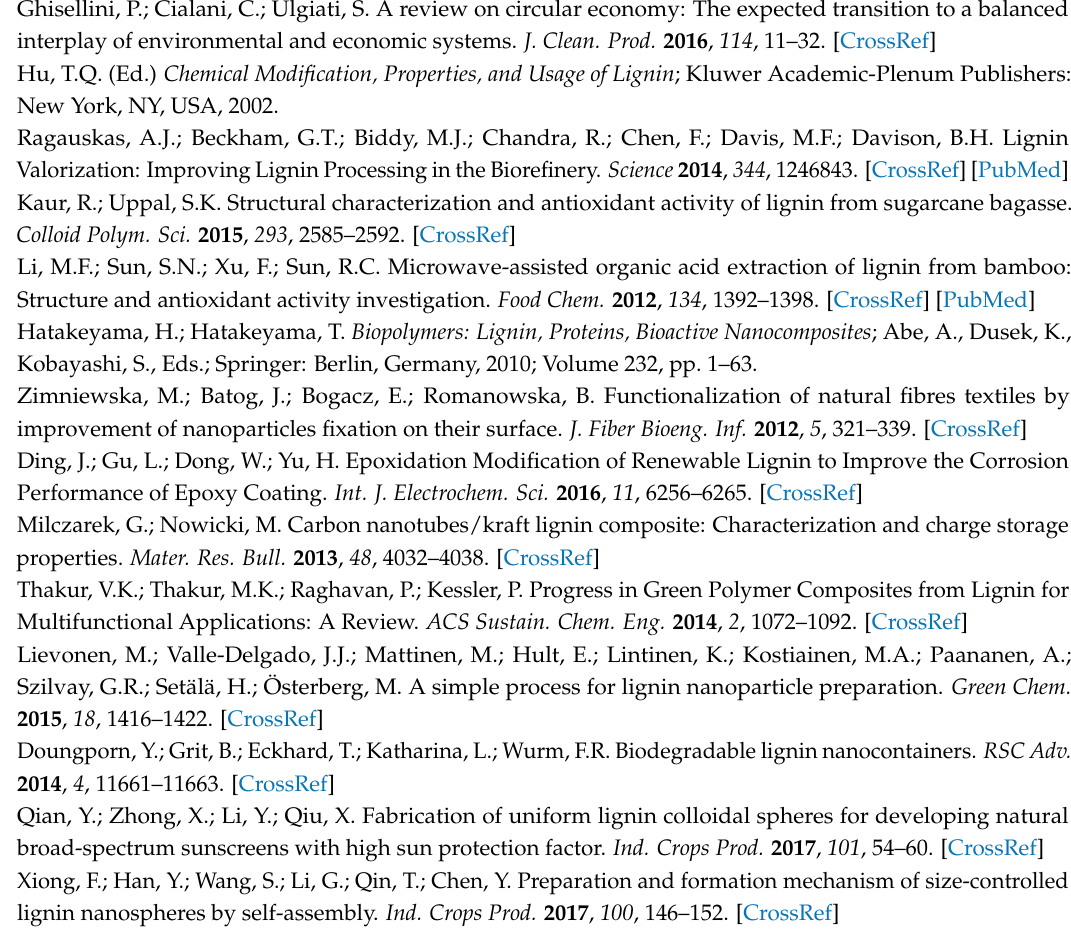
Figure S1: Gel Permeation Chromatography (GPC) of lignin Organosolv (OL black line) and after the treatment with tyrosinase (OL-tyr grey line), Figure S2: The UV-vis absorption spectra of OL nanoparticles coated with PDDA. Author Contributions: E.C. and D.P. synthesized and characterized the catalysts, and analyzed the kinetic